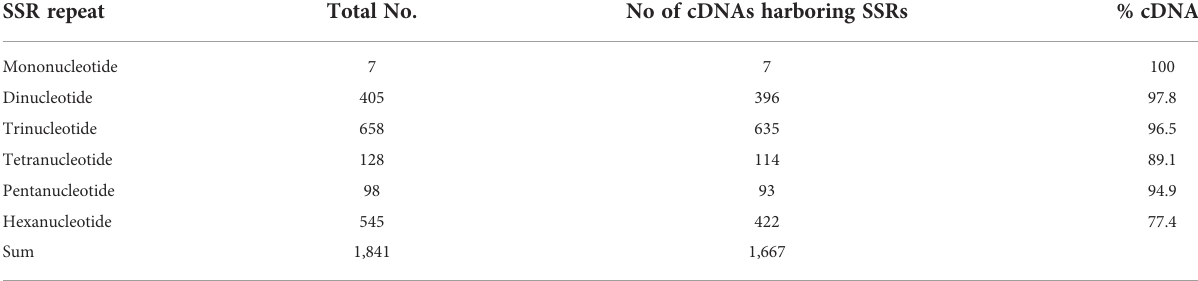
TABLE 2 Distribution of SSR repeats in cDNA clones. SSR repeat Total No.